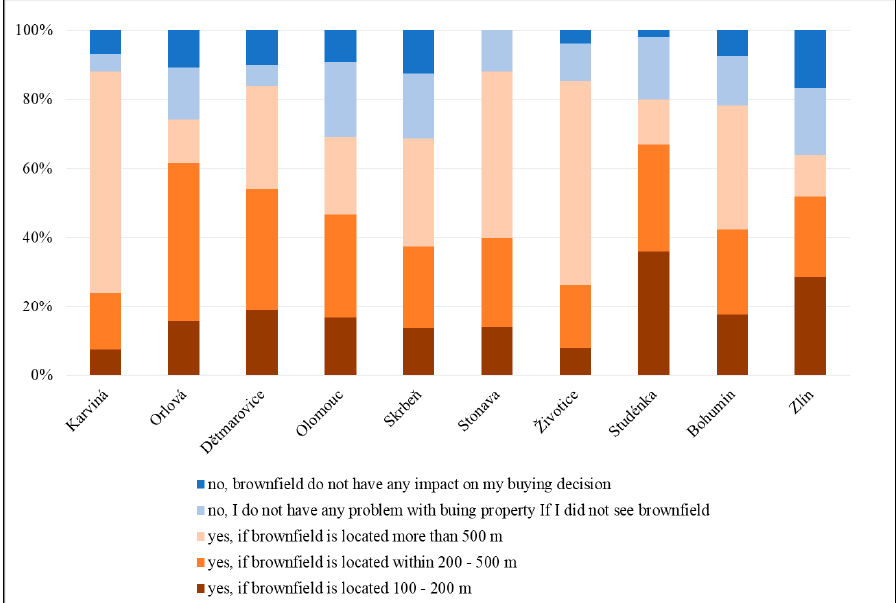
Figure 5. Influence of distance of brownfields on real estate purchase behaviour of respondents. Source: own survey (n = 1,152).